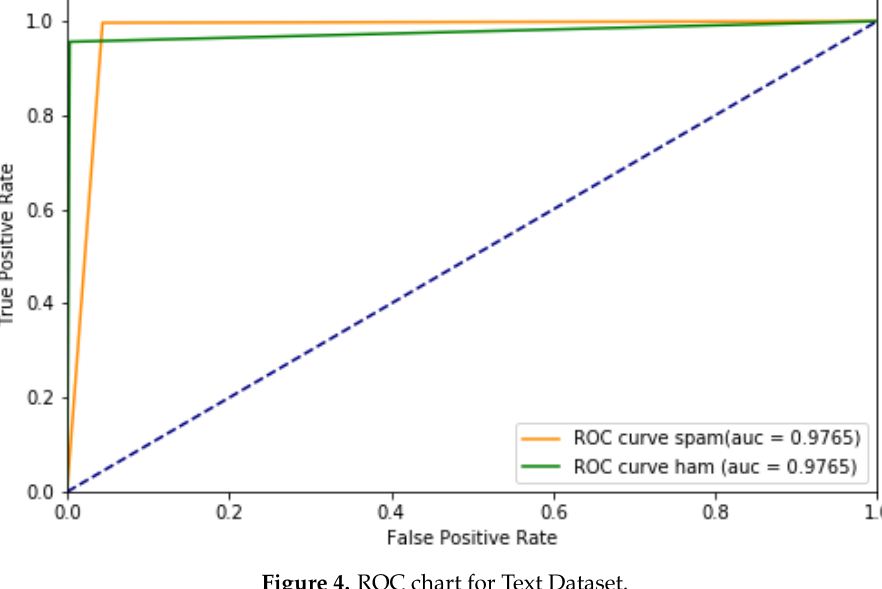
Figure 4. ROC chart for Text Dataset.